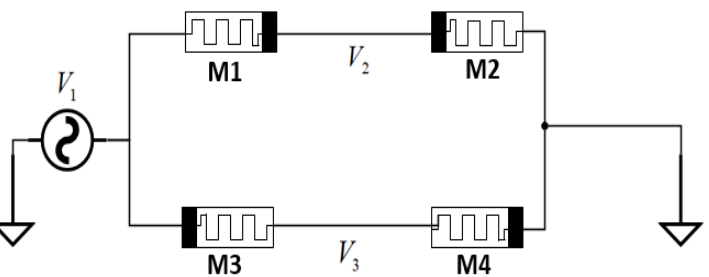
Figure 6. Memristor-based read/write circuit with stable successive read operation. (1) Write operation . During the write operation, when the voltage source releases the forward voltage, M1 and M4 are equivalent to applying the positive voltage, the dividing line shifts to the undoped region, the memristors M1 and M4 are in the low resistance state, and the logic “1” is stored in M1. At the same time, M2 and M3 are equivalent to applying the reverse voltage, the dividing line shifts to the doped region, and the memristors M2 and M3 are in the high resistance state. When the voltage source releases a negative voltage, M1 and M4 are equivalent to applying a reverse voltage, the boundary is shifted to the doped region, the memristors M1 and M4 are in a high resistance state, and the logic “0” is stored in M1. At the same time, M2 and M3 are equivalent to applying a positive voltage, the boundary is shifted to the undoped region, and the memristors M2 and M3 are in a low resistance state. (2) Read operation. During the read operation, the input reading signal is a low voltage signal with positive, and the output voltage value V o is the difference between V 2 and V 3 . When reading logic “1”, M1 and M4 are in low resistance state R on , M2 and M3 are in high resistance state R of f , and the resistance values of V 2 and V 3